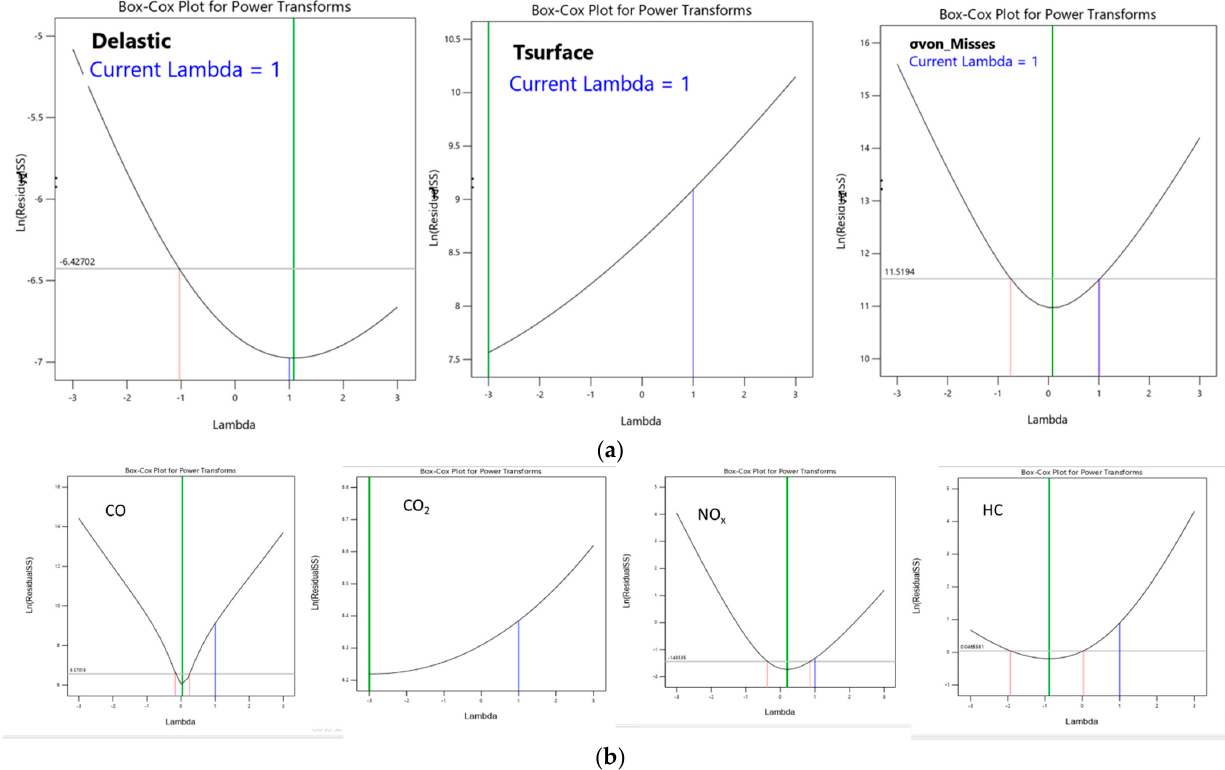
Figure 11. Box–Cox plot for power transform:( a ) elastic response, ( b )emission response.